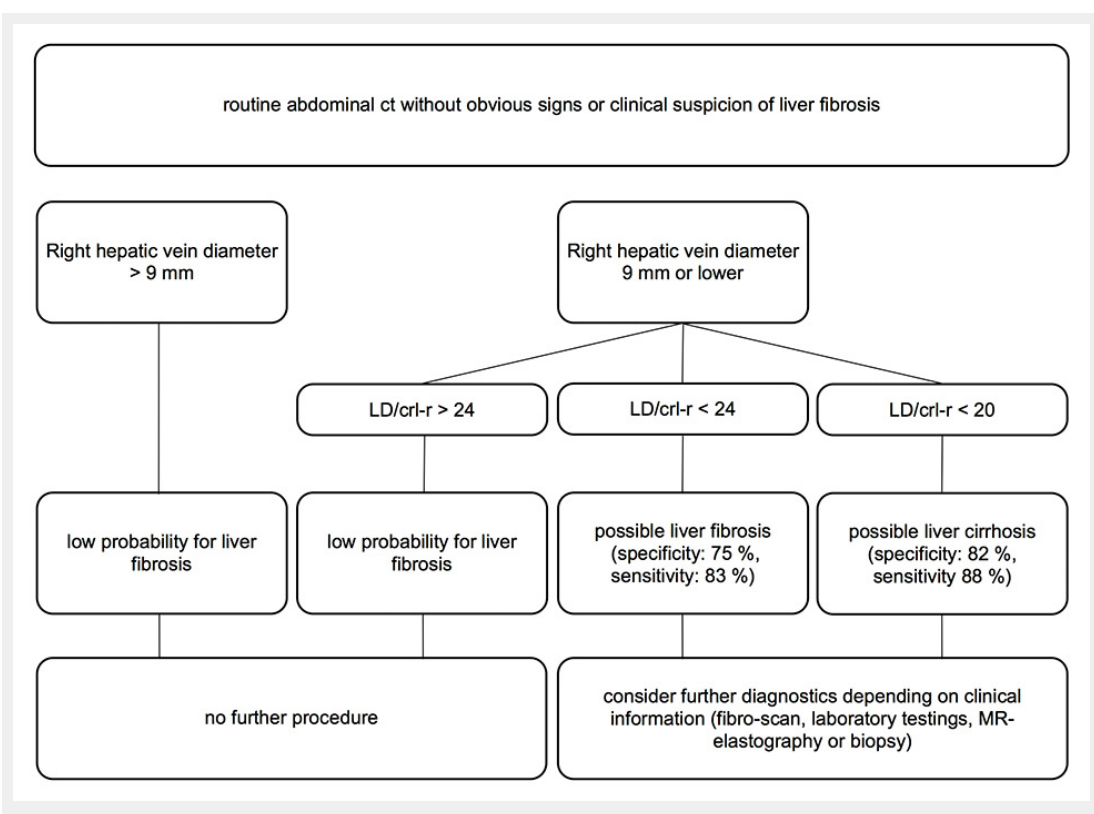
Figure 5 Possible work-up procedure for routine abdominal diagnostic examinations of patients without any suspicion of liver fibrosis. Increasing the right vein diameter threshold from 0.7 to 0.9 cm increased the sensitivity for fibrosis from 69% to 90% and prevented the exclusion of too many false- negative patients. ct = computed tomography; MR = magnetic resonance; crl-r = caudate-right lobe ratio; LD score = sum of liver vein diameters; LD/crl-r = LD score divided by